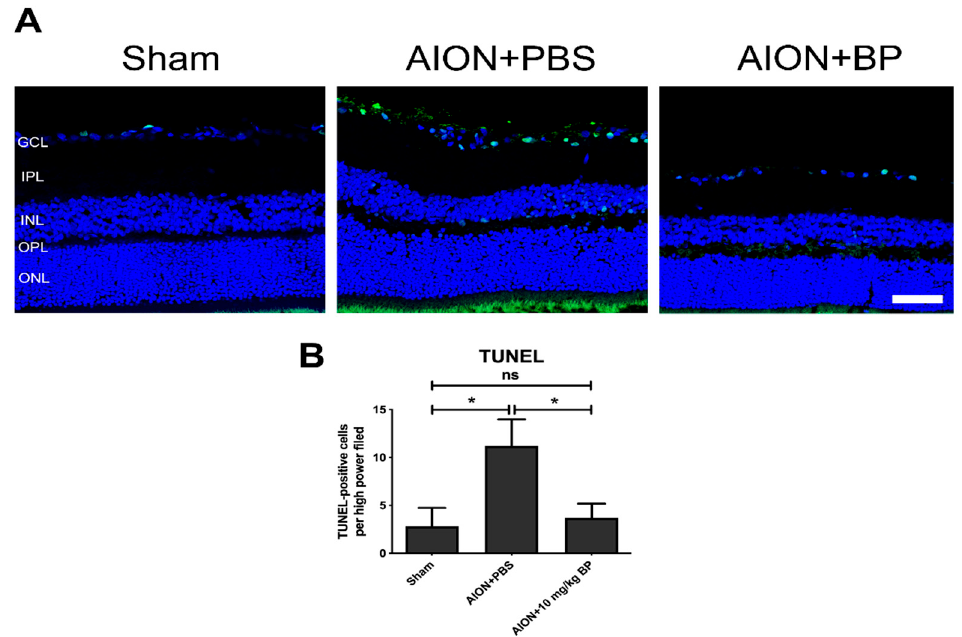
Figure 5. Detection of RGC apoptosis by TUNEL assay. TUNEL-stained image of retinal cross- sections in each group ( A ). Apoptotic cells were counted in the sham, PBS-treated, and BP-treated groups and were 2.8 ± 1.9, 11.2 ± 2.8, and 3.7 ± 1.5 TUNEL-positive cells/HPF, respectively. Scale bar = 50 μ m ( B ). (*, p ≤ 0.05; n.s., not significant; n = 6. GCL: ganglion cell layer; IPL: inner plexiform layer; INL: inner nuclear layer; OPL: outer plexiform layer; ONL: outer nuclear layer.)